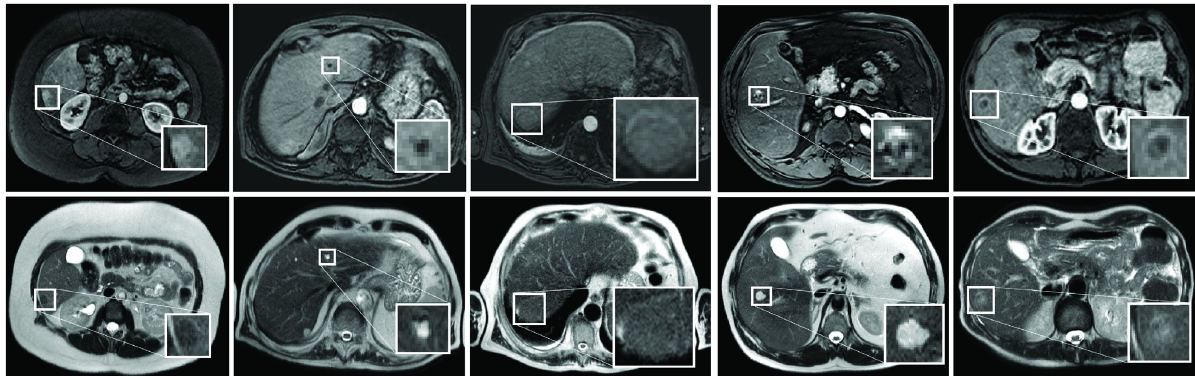
Fig 1. Examples of focal liver lesions. From left to right livers with an adenoma, cyst, HCC, hemangioma, and a metastasis from colorectal carcinoma origin are shown. The top row shows the arterial phases of the DCE-MRI and the bottom row the T2-weighted images. A zoom-in of the lesions is